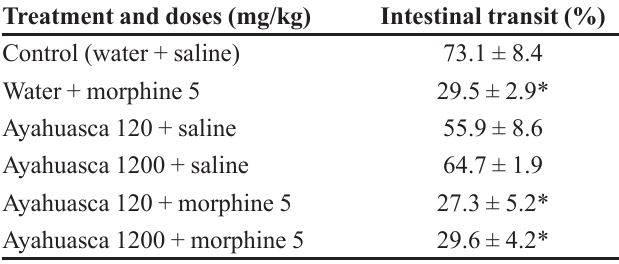
TABLE I - Effect of ayahuasca (120 and 1200 mg/kg, p.o.) and its association with morphine (5 mg/kg, i.p.) in the distance traveled by activated charcoal in the small intestine (percentage of the total length). Results are expressed as the mean ± SEM (n=5) Treatment and doses